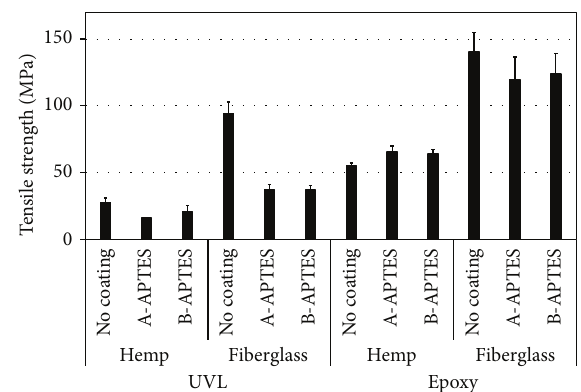
Figure 4: Effect of fiber coating on tensile strength of epoxy and UVL composites.